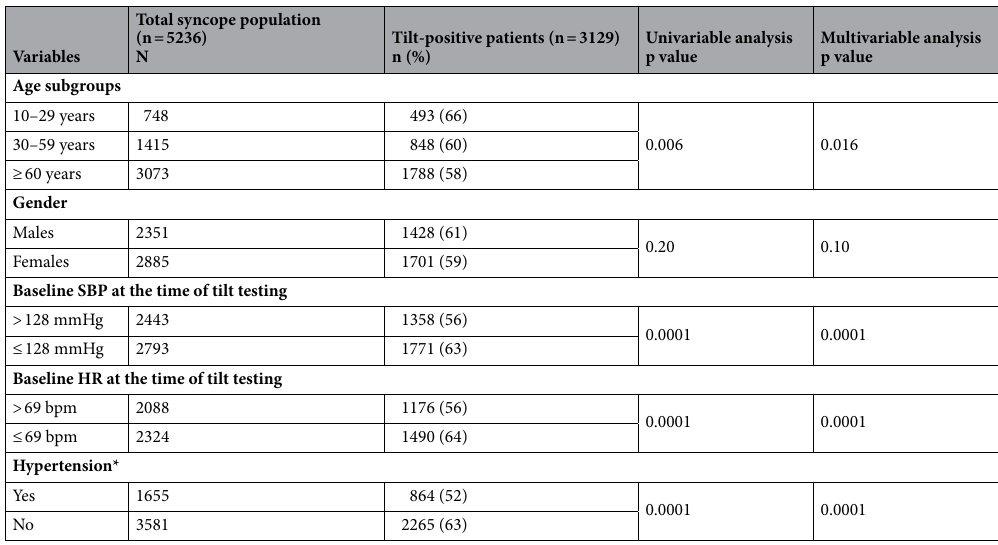
Table 1. Univariable and multivariable analysis of factors predicting tilt test positivity in patients investigated for unexplained syncope using the Italian tilt test protocol. SBP systolic blood pressure , HR heart rate . * Adjusted for age, gender and heart